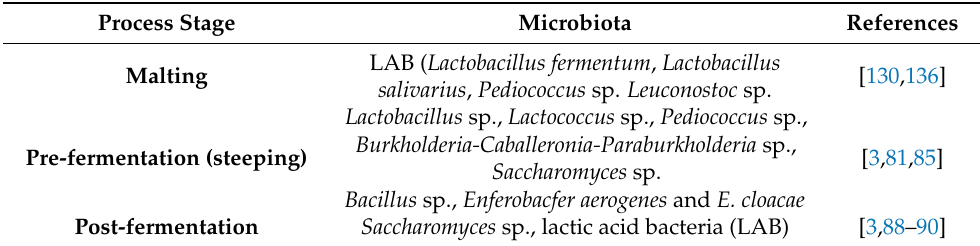
Table 3. Summary of microbiota in Kunu beverages based on processing